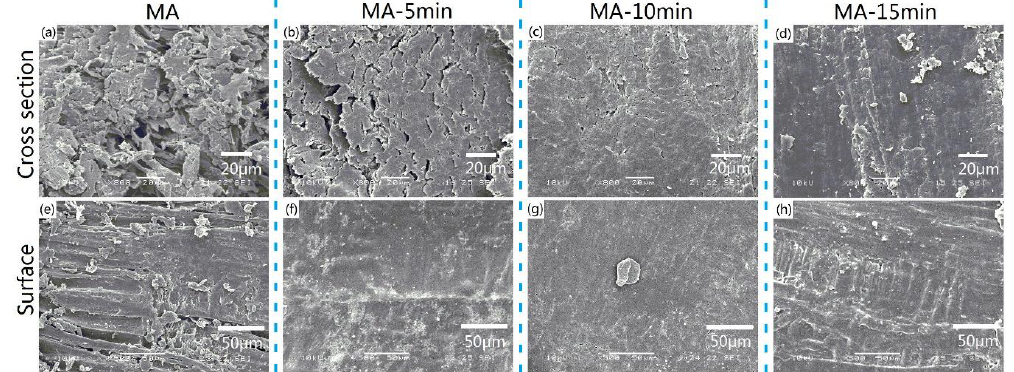
Figure 8. SEM micrographs of the cross section of samples: ( a ) MA, ( b ) MA-15min, ( c ) MA-30min, ( d ) MA-45min and SEM micrographs of the surface of samples: ( e ) MA, ( f ) MA-15min, ( g ) MA-30min, ( h ) MA-45min.